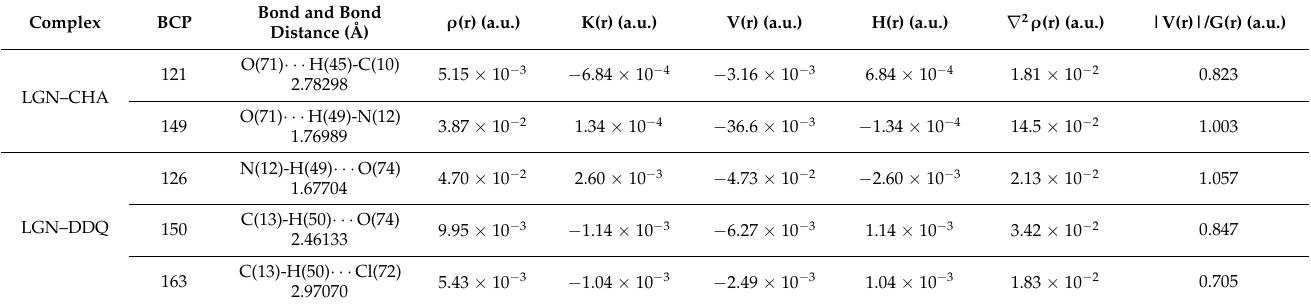
Table 2. Calculated Hydrogen Bonding Interaction Parameters: Hydrogen Bond Distance ((r, Å), Electron Density, Electron Density Laplacian and Energy Density at the H · · · O BCPs ( ρ (r), ∇ 2 ρ (r), and H(r), au), |V(r)|/G(r)